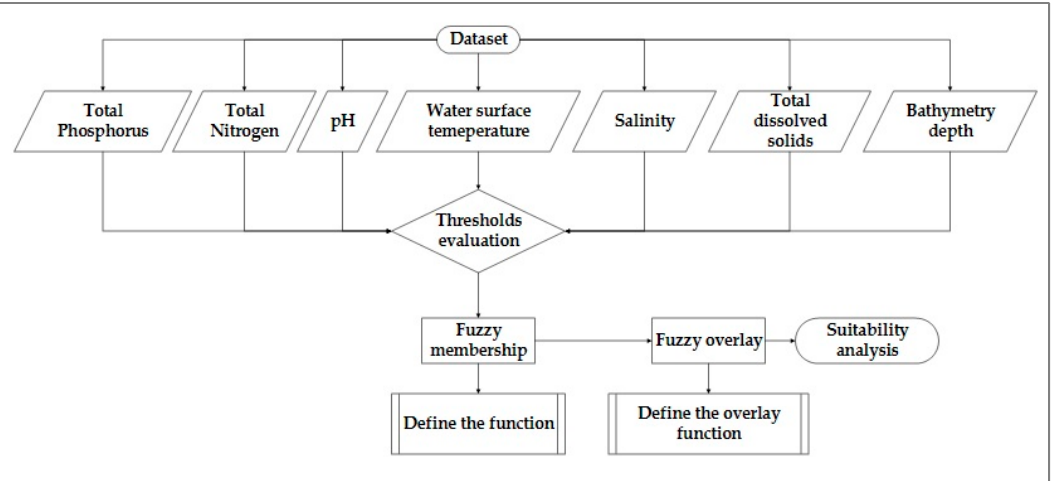
Figure 3. Flow chart for multi-criteria spatial model using fuzzy overlay developed to identify the potential water hyacinth infestation